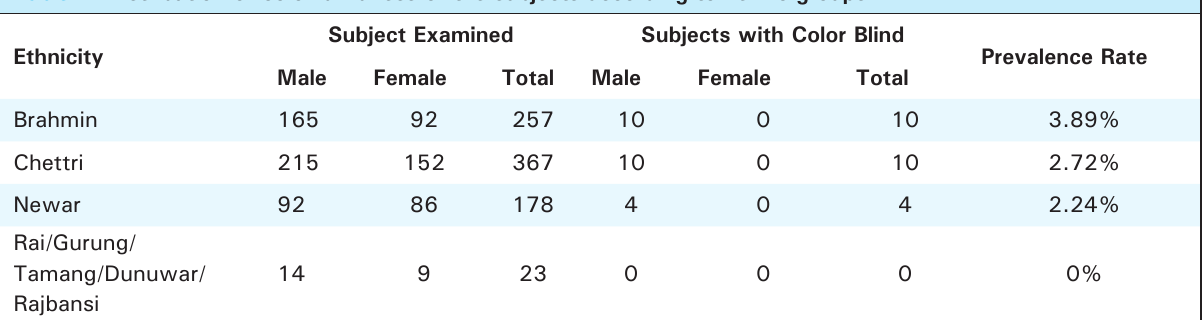
Table 4. Distribution of color blindness of the subjects according to Ethnic groups. Subject Ethnicity